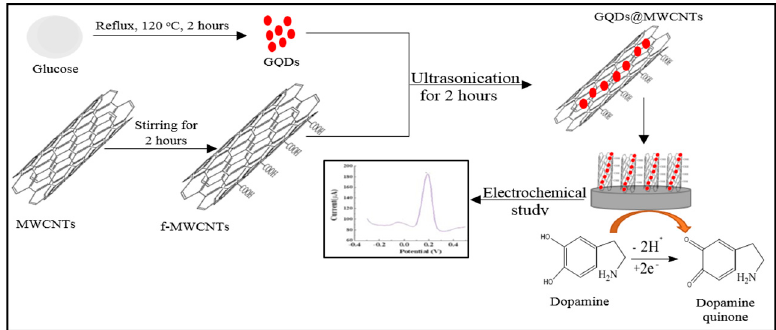
Figure 12. GQDs production and electrochemical detection of DA using GQDs@MWCNTs composite (adapted from [113], 2020).